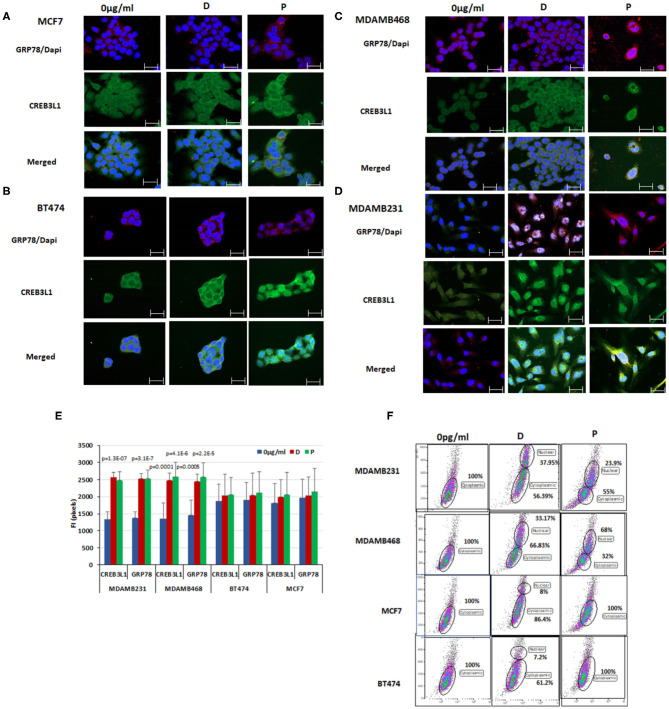
Chemotherapy induced nuclear translocation of CREB3L1 in MDAMB231 cells. Immunofluorescence analysis of GRP78 and CREB3L1 expression 24 h after cell treatment with doxorubicin and paclitaxel: (A) MCF7 cells, (B) BT474 cells, (C) MDAMB468 cells, (D) MDAMB231 cells. Note GRP78 staining (red), CREB3L1 staining (green), and merged staining (yellow) by cell type (63 × magnification, scale bar = 10 μm). (E) Fluorescence intensity (FI) of CREB3L1 and GRP78 expression. (F) Dot Blot FACS analysis of the cytoplasmic and nuclear expression of CREB3L1 in the different breast cancer cell lines.